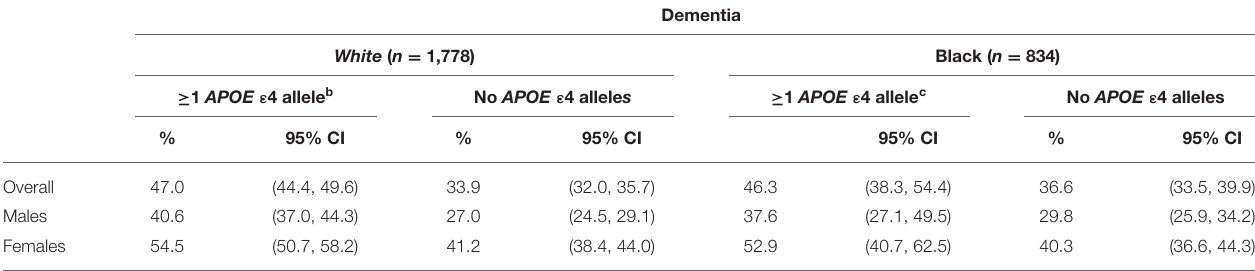
TABLE 3 | Proportion experiencing dementia diagnosis by APOE ε 4 s tatus in the ARIC cohort ( N = 13,782) a